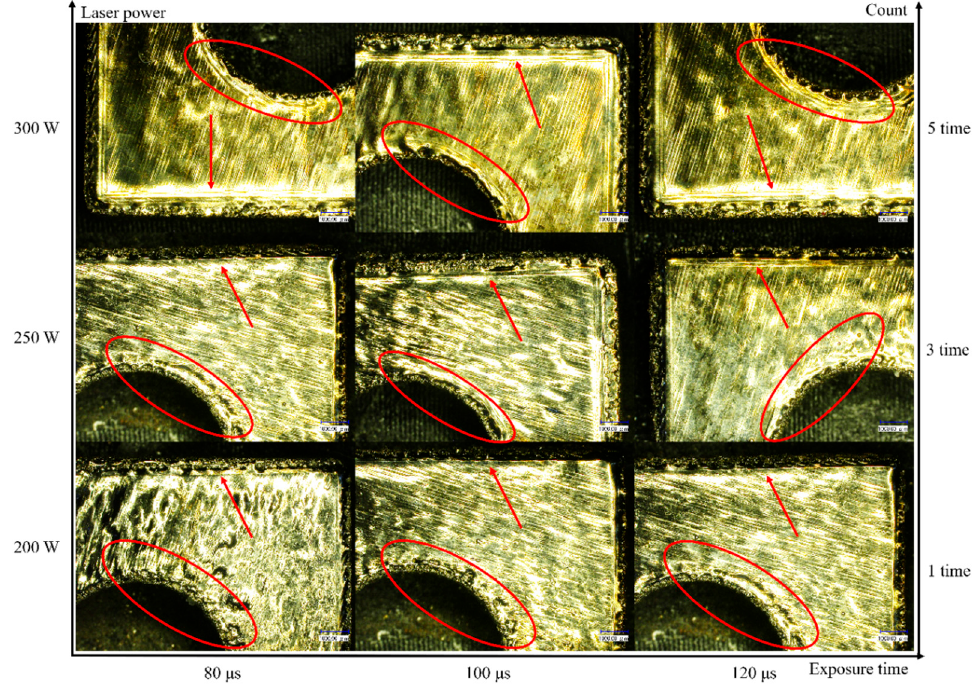
Figure 11. Forming boundary quality of different boundary strategies under 50 μ m layer thickness.